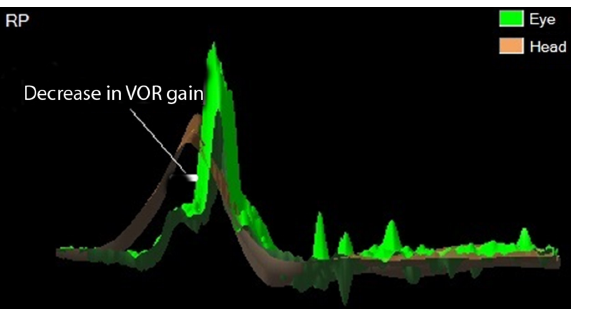
Figure 1. The 3D image of the decrease in vestibulo-ocular reflex gain in the right posterior semicircular canal. Table 4. The Dispersion of LL, RL, LA, RP, LP, and RA Parameters in Groups with Respect to O/C Saccade Existence Group